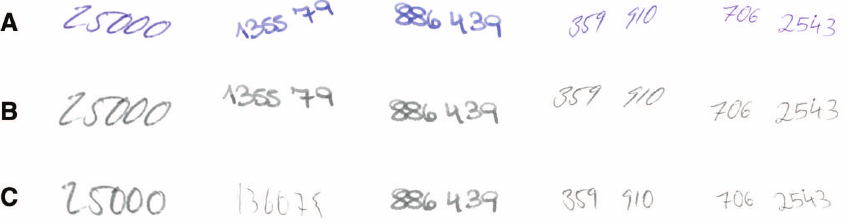
Figure 12: Each Row of the Figure Represents the Performance of our Proposed Method on Digit Strings. (A) Three sample images. (B) Outputs after skew correction. (C) Final outputs after slant